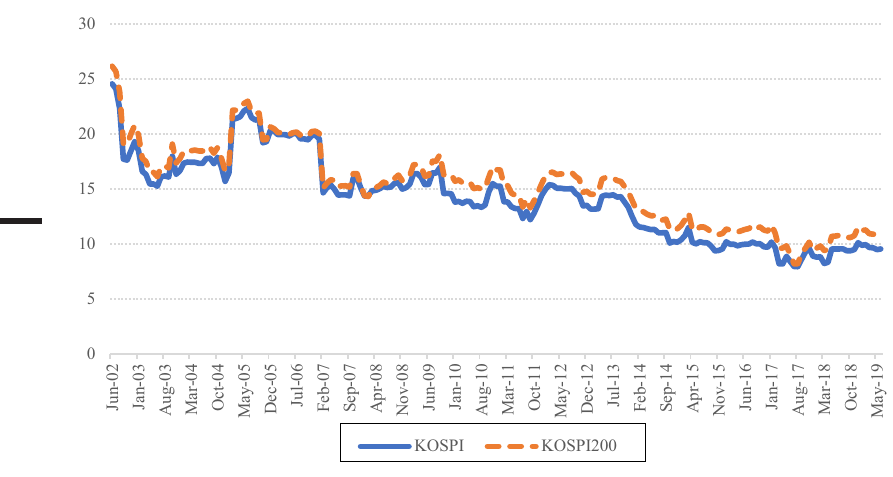
Figure 2. Time-series of tracking errors estimated from style combining strategy